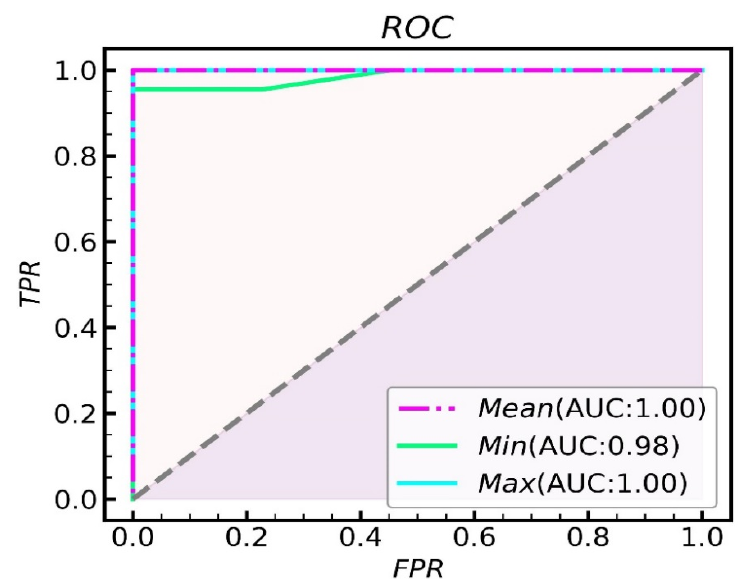
Figure 7. ROC curve of recognition rate.